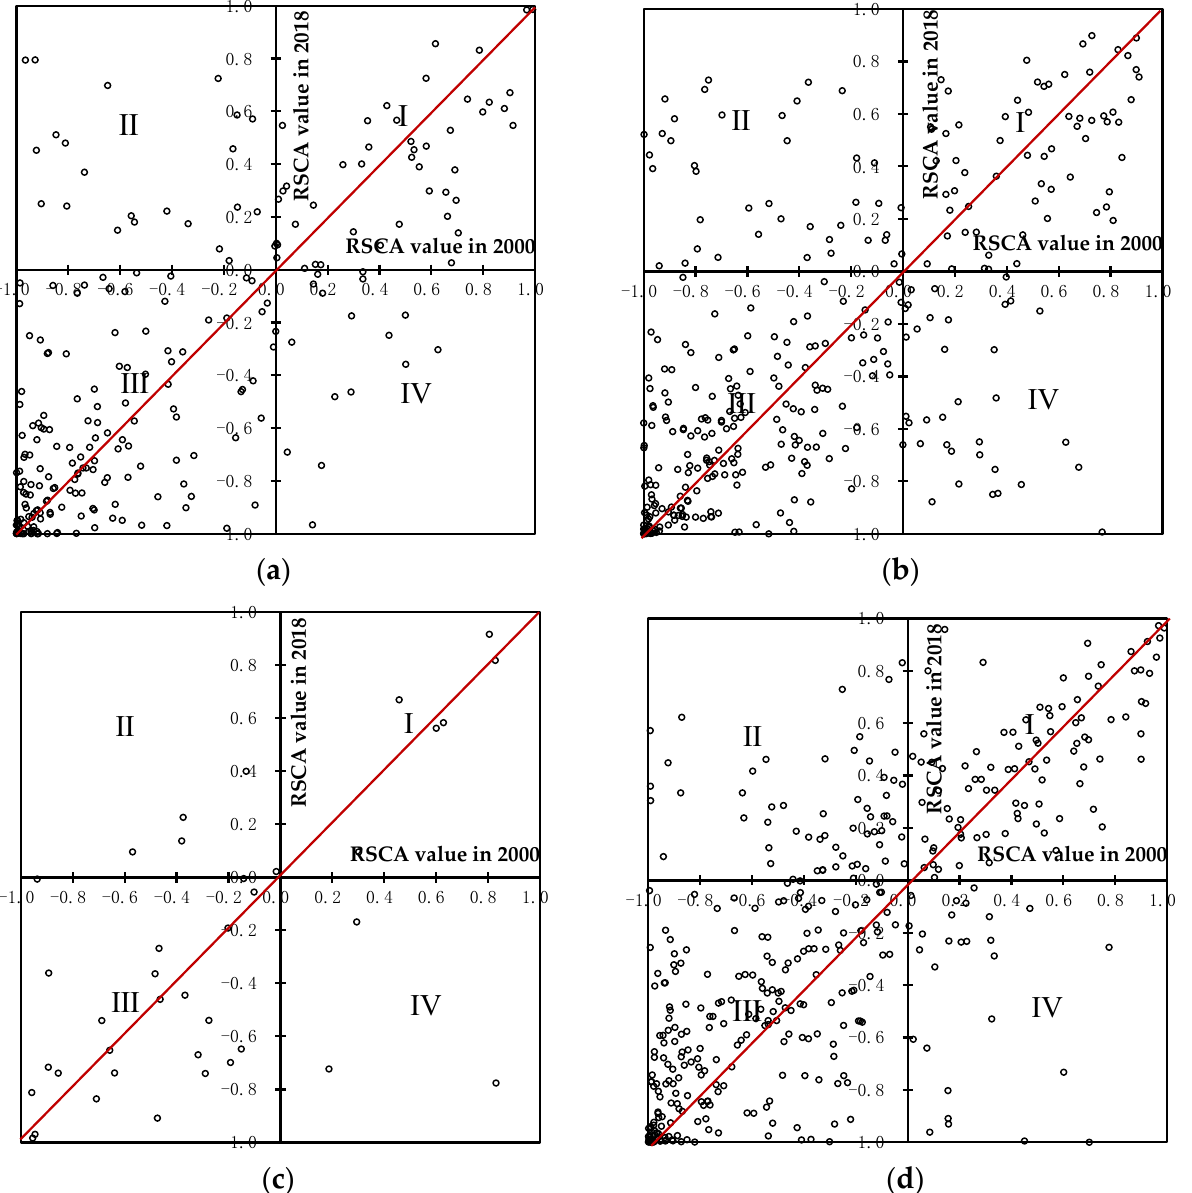
Figure 4. The distribution of the RSCA values of 4 categories of agricultural products in countries along the B&R in 2000 and 2018. ( a ) the first category of agricultural products (live animals and animal products, including HS01–HS05 and HS50–HS51); ( b ) the second category of agricultural products (plant products, including HS06–HS14 and HS52–HS53); ( c ) the third category of agricultural products (animal and vegetable oils and fats, including HS15); ( d ) the fourth category of agricultural products (food, beverages and tobacco, including HS16–HS24). The x -axis represents the RSCA value in 2000; and the y -axis represents the RSCA value in 2018.